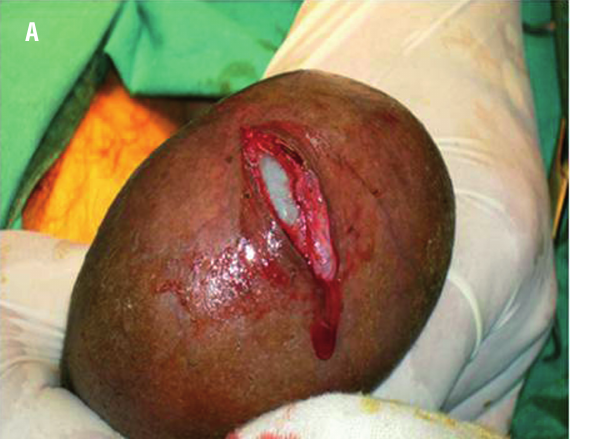
Figure 1B - An operative photograph showing delivery of the hydrocele sac through the small scrotal